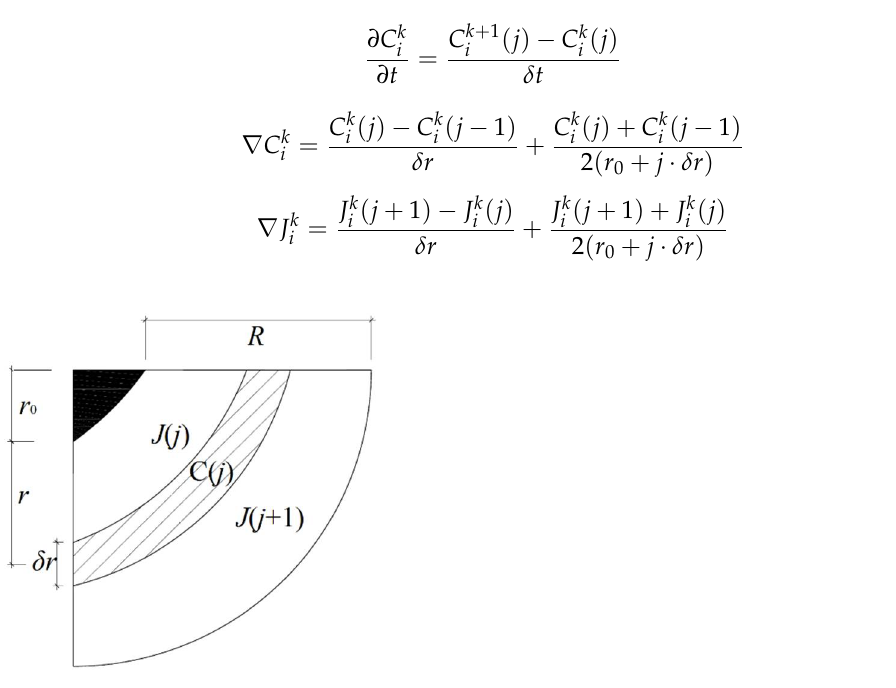
Figure 2. Schematic illustration of the finite difference method.